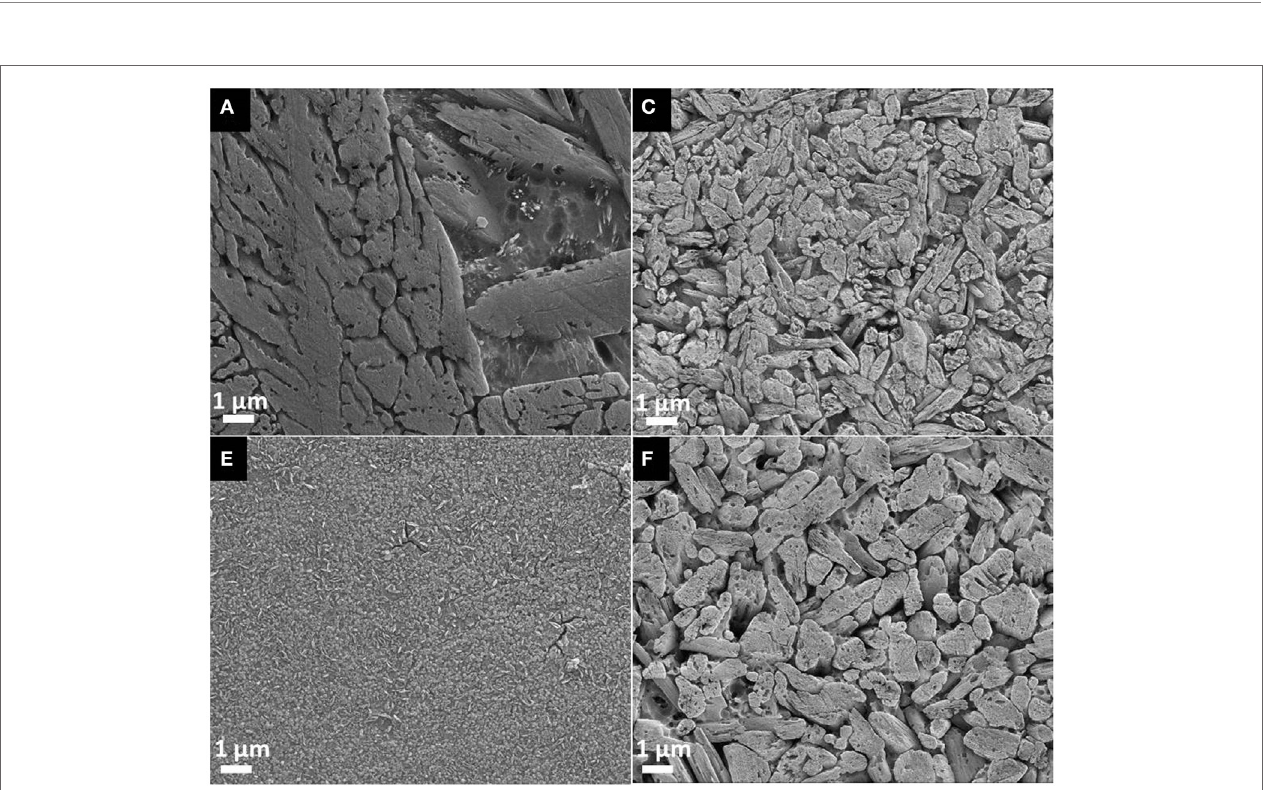
FigUre 4 | Microstructure of glass–ceramics a, c, e, and F crystallized for 30 min at 800°c, polished and subsequently etched in 40% hF vapor for 30 s .